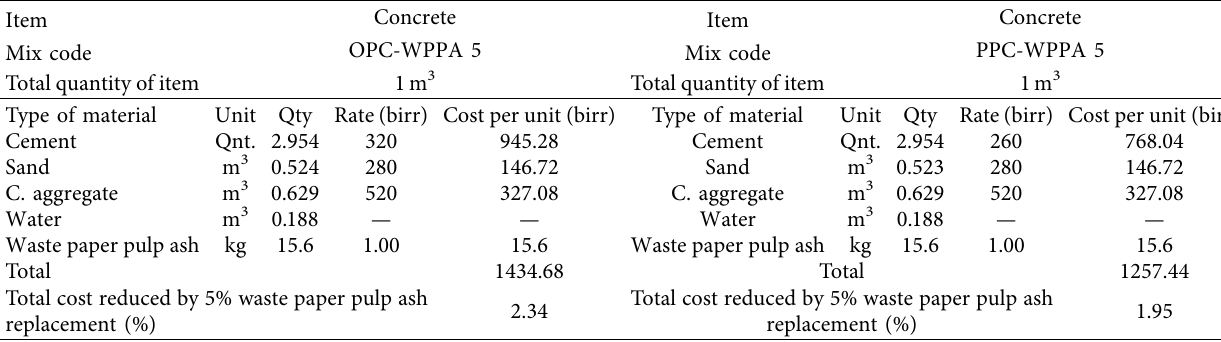
Table 17: OPC-WPPA5 and PPC-WPPA5.